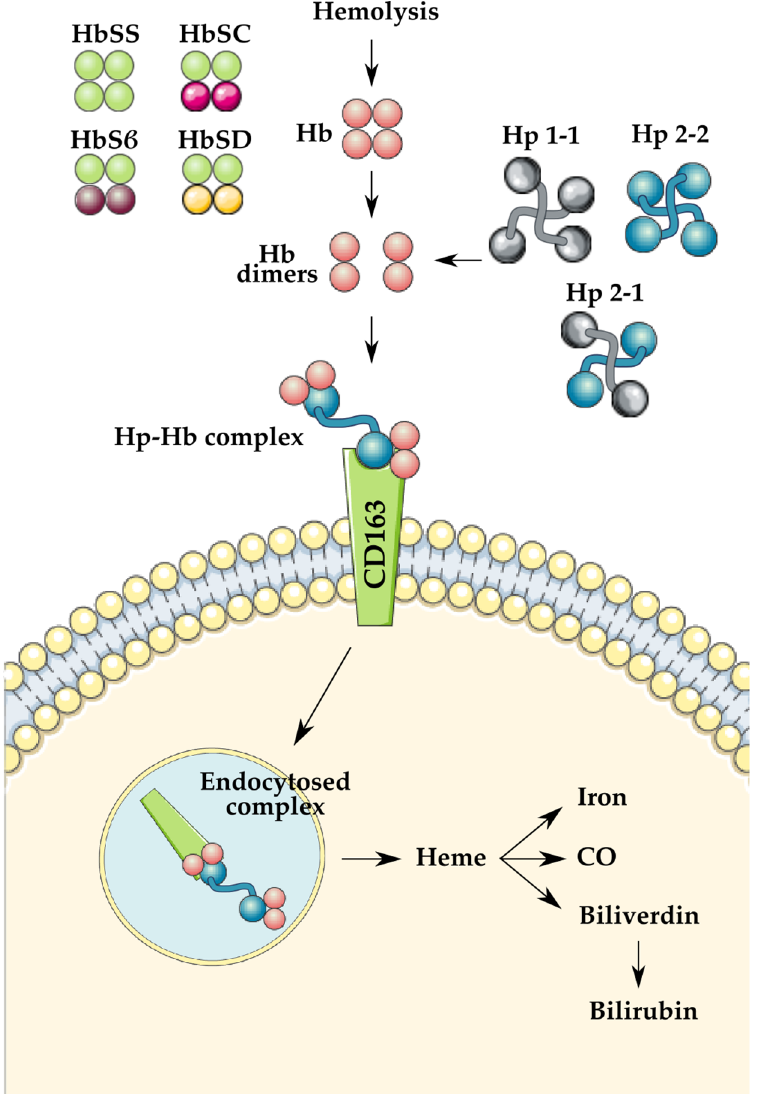
Figure 1. Demonstration of the role of haptoglobin (Hp) in hemoglobin (Hb) clearance following hemolysis. The previously mentioned variants of Hb and Hp are illustrated on the left and the right, respectively. Illustrations used were created by SMART Servier Medical Art under Creative Commons Attribution 3.0 Unported Licensing at https://smart.servier.com/, accessed on 12 November 2021.